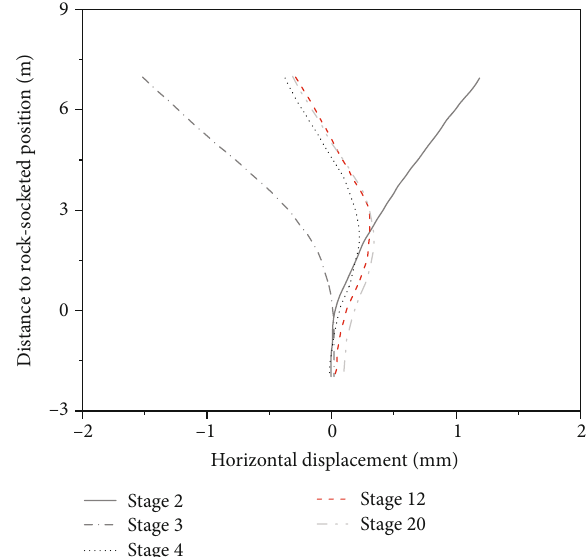
Figure 13: Variation of horizontal displacement of end-suspended pile with construction stage.